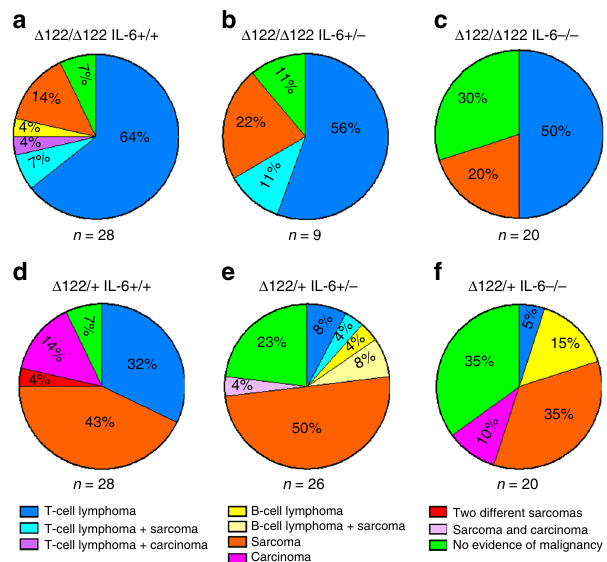
Fig. 2 Loss of IL-6 in Δ 122p53 mice reduces tumour incidence. a – f Percentage of tumour types identi fi ed by histopathological analysis displayed as pie charts for each genotype. n = cohort size. All cohorts of mice were followed for up to 600 days and mice were culled when signs of disease or distressed were observed